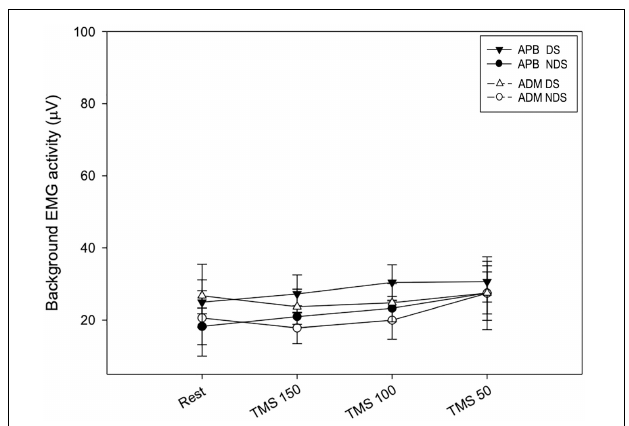
FIGURE 4 | Background EMG activity at rest and after TMS. No changes were reported at rest and after TMS at the three intervals. Data expressed as mean ± standard deviation. APB, abductor pollicis brevis; ADM, abductor digiti